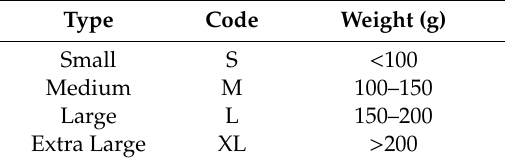
Table 5. Cucumber classification.